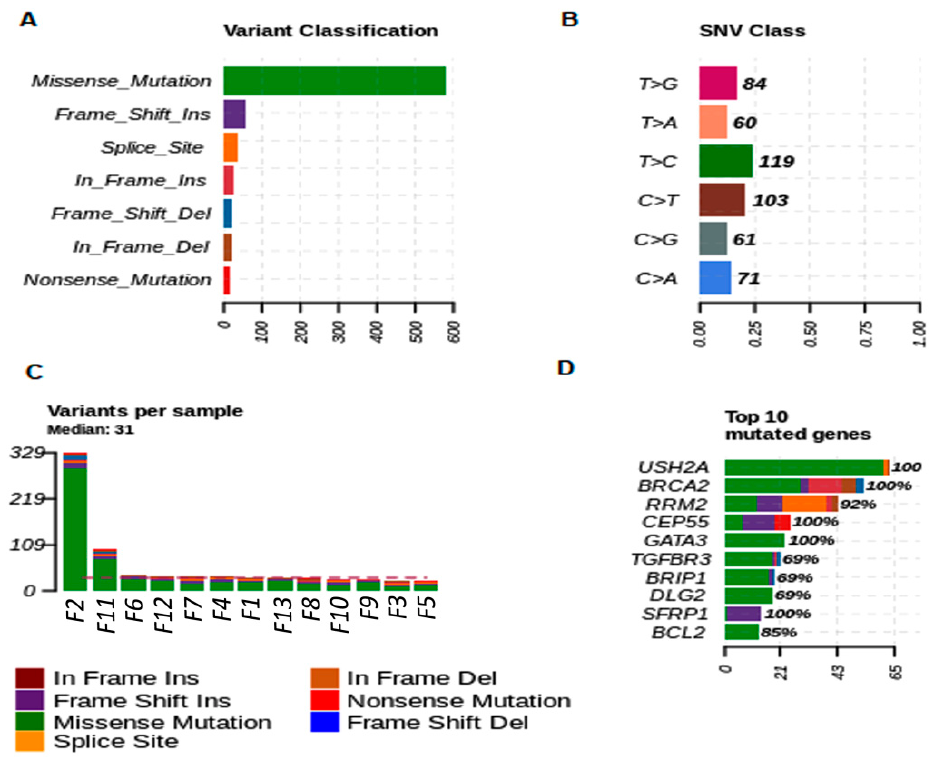
Figure 4. Genetic variation in tumor fragments of dogs with BC. ( A ) Representative variant classification. ( B ) Single- nucleotide variant (SNV) classification. ( C ) Representative variants per fragment sample. ( D ) Top mutated genes showing multiple variant mutations. Graphics were generated in the R language, using the Maftools package.